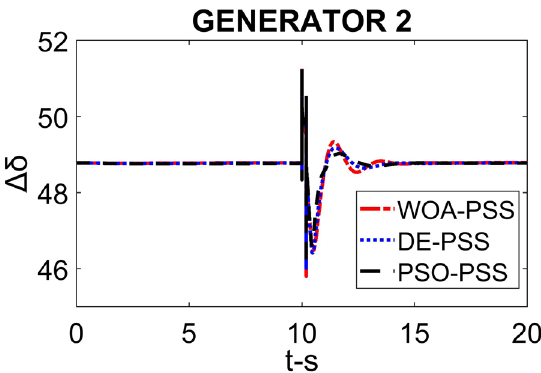
Fig. 18 delta deviation of G2 under 3- φ fault at t = 10 s